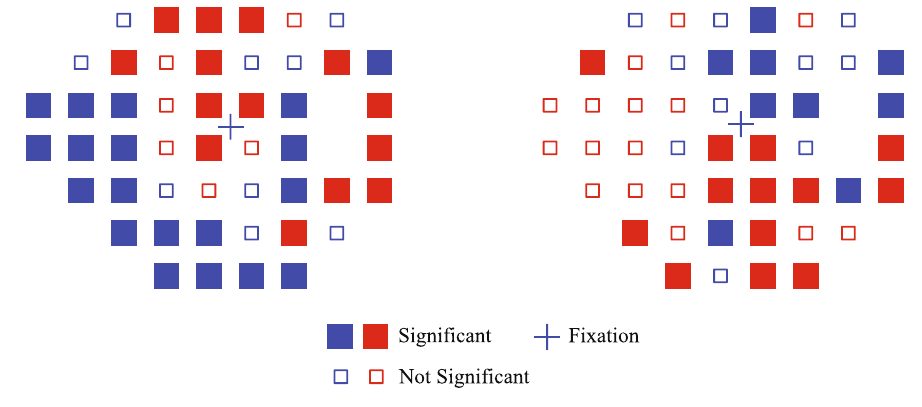
→ is the length scale of the kernel and ||.|| is the l 2 norm 35–37 . → based on the observational data.